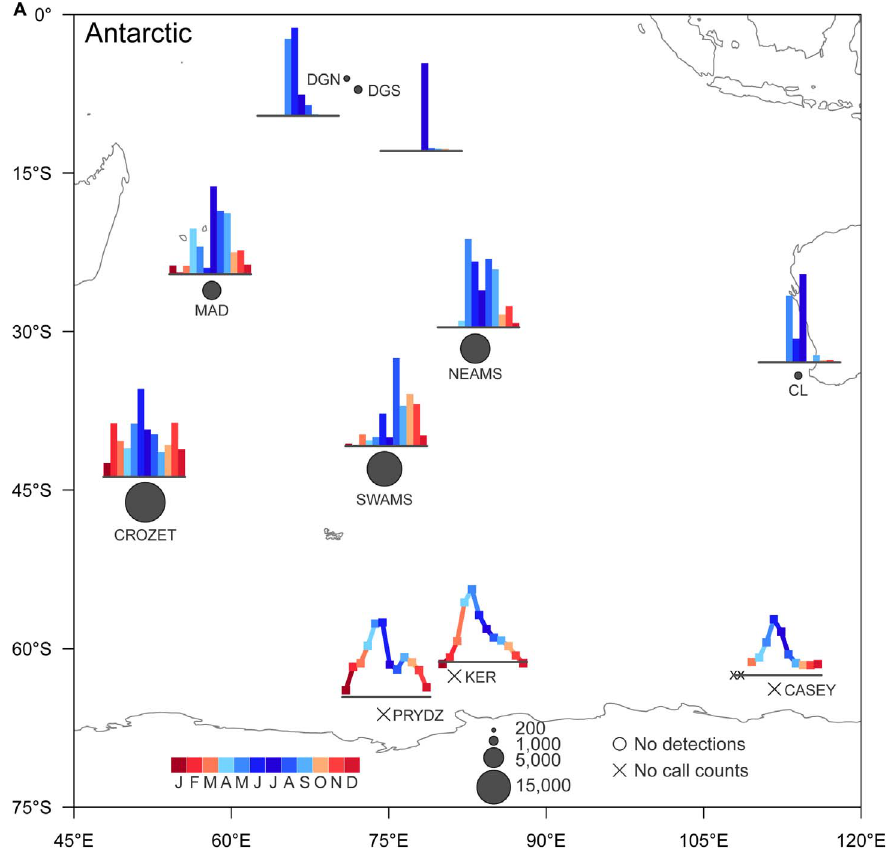
Figure 5. Monthly and geographic patterns of call detections of southern blue whale subspecies in the Indian Ocean. A: Antarctic call type; B: Sri Lanka call type; C: Madagascar call type; D: Australia call type. Circle size reflects the maximum number of calls received in a single month, X indicates no data were available, O indicates that no calls were detected. The bars at each location are the number of calls in that month divided by the maximum number of calls in a month at that location. The lineplots at locations PRYDZ, KER and CASEY are not number of calls detected but power spectral density ratios of acoustic energy in whale call vs. surrounding frequency bands (e.g. [14,52]).